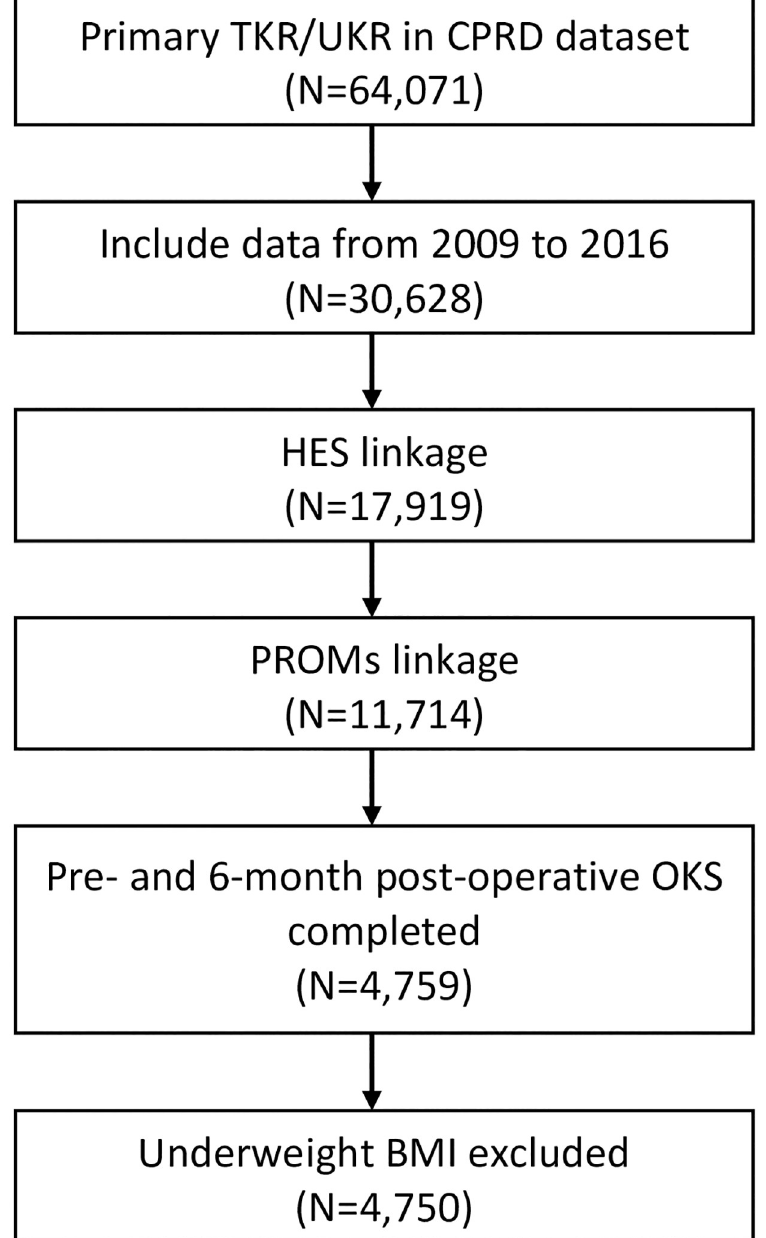
Fig 1. Patient flow diagram. TKR/UKR, total and uni-compartmental knee replacement; CPRD, Clinical Practice Research Datalink GOLD; HES, English Hospital Episode Statistics; PROMs, Patient Reported Outcome Measures; OKS, Oxford Knee Score; Underweight BMI, Body Mass Index under 18.5 Kg/m 2 .